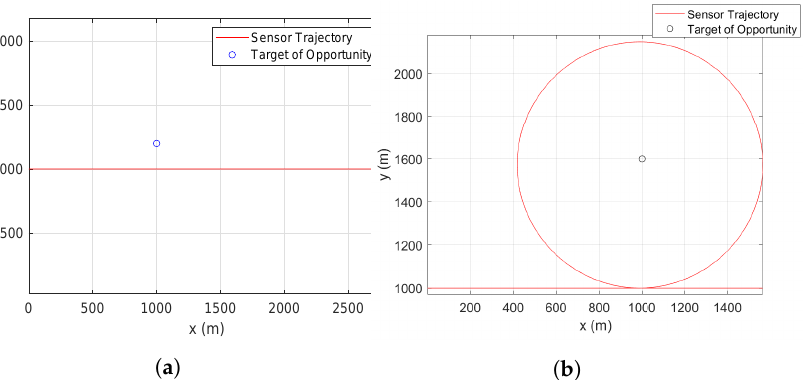
Figure 2. Sensor trajectories for bias estimation using a stationary target with known location and terrain uncertainty. Sensor trajectory follows: ( a ) the CV model, ( b ) the CV-CT